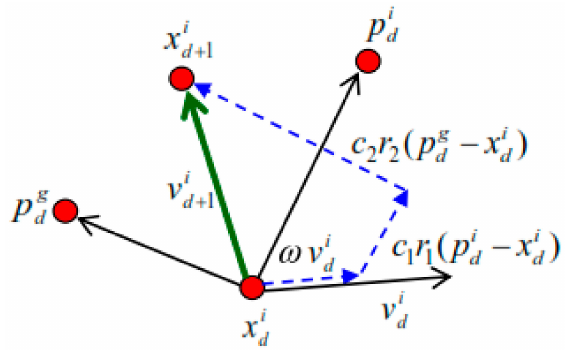
Figure 8. Particle swarm optimization (PSO) algorithms